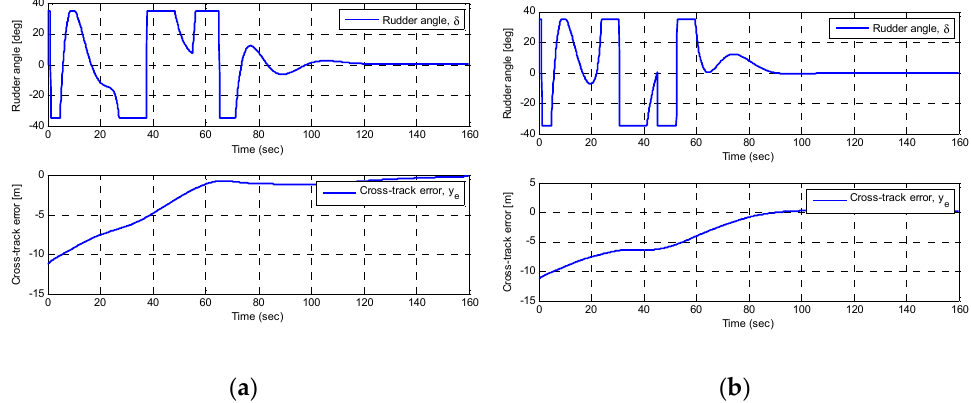
Figure 15. Rudder angle, cross-track errors: ( a ) multi round obstacle; and ( b ) multi rectangular obstacle.